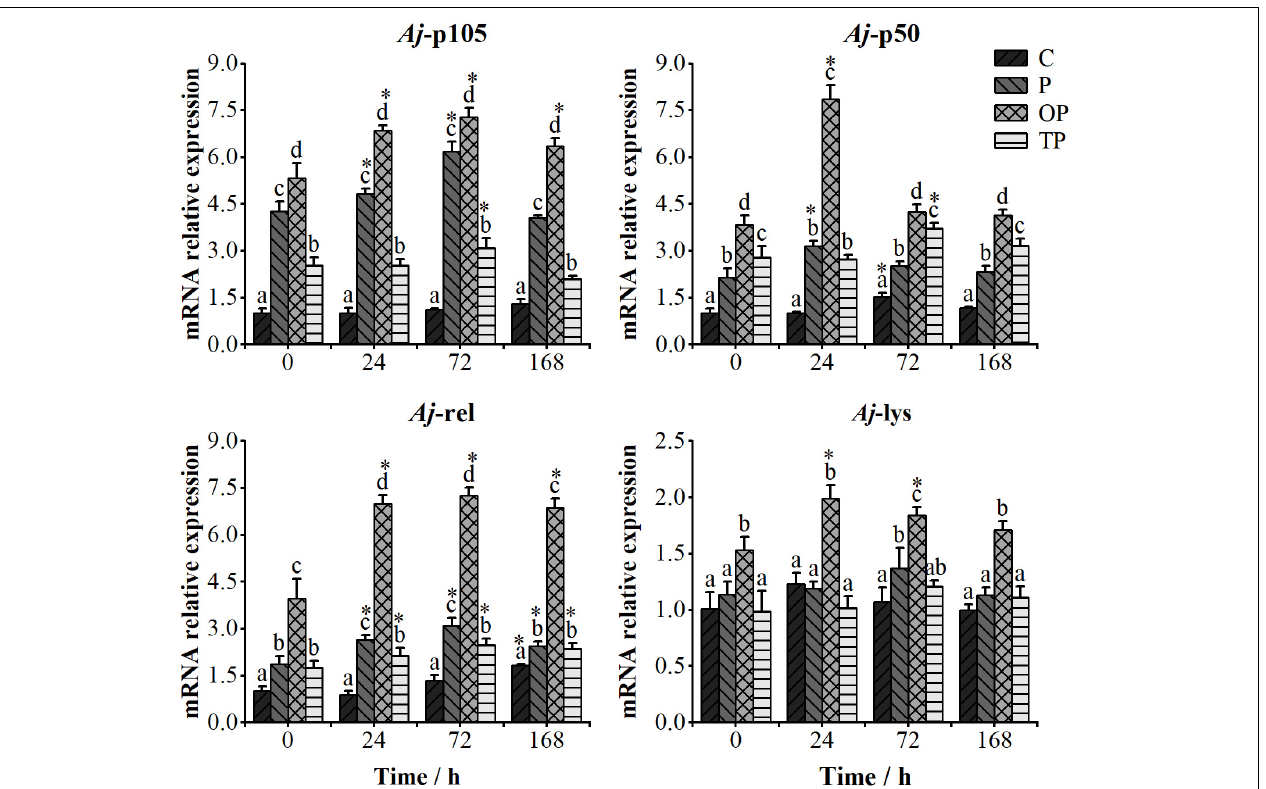
FIGURE 2 | Relative expression levels of the Aj -p105, Aj -p50, Aj -rel, and Aj -lys genes in the mid-intestine tissue of the sea cucumbers at 0, 24, 72, and 168 h after stimulating by inactivated Vibrio splendidus . The time point of 0 h represents the relative expression level of immune-related genes at the end of the 63 days feeding trial. Bars represent mean ± SE ( n = 5). Different letters at the same time point represent significant differences ( P < 0.05). * stands for significantly different immune-related genes expression levels between the different time points and 0 h time point ( P < 0.05). C (control): basal diet; P: basal diet supplementation with